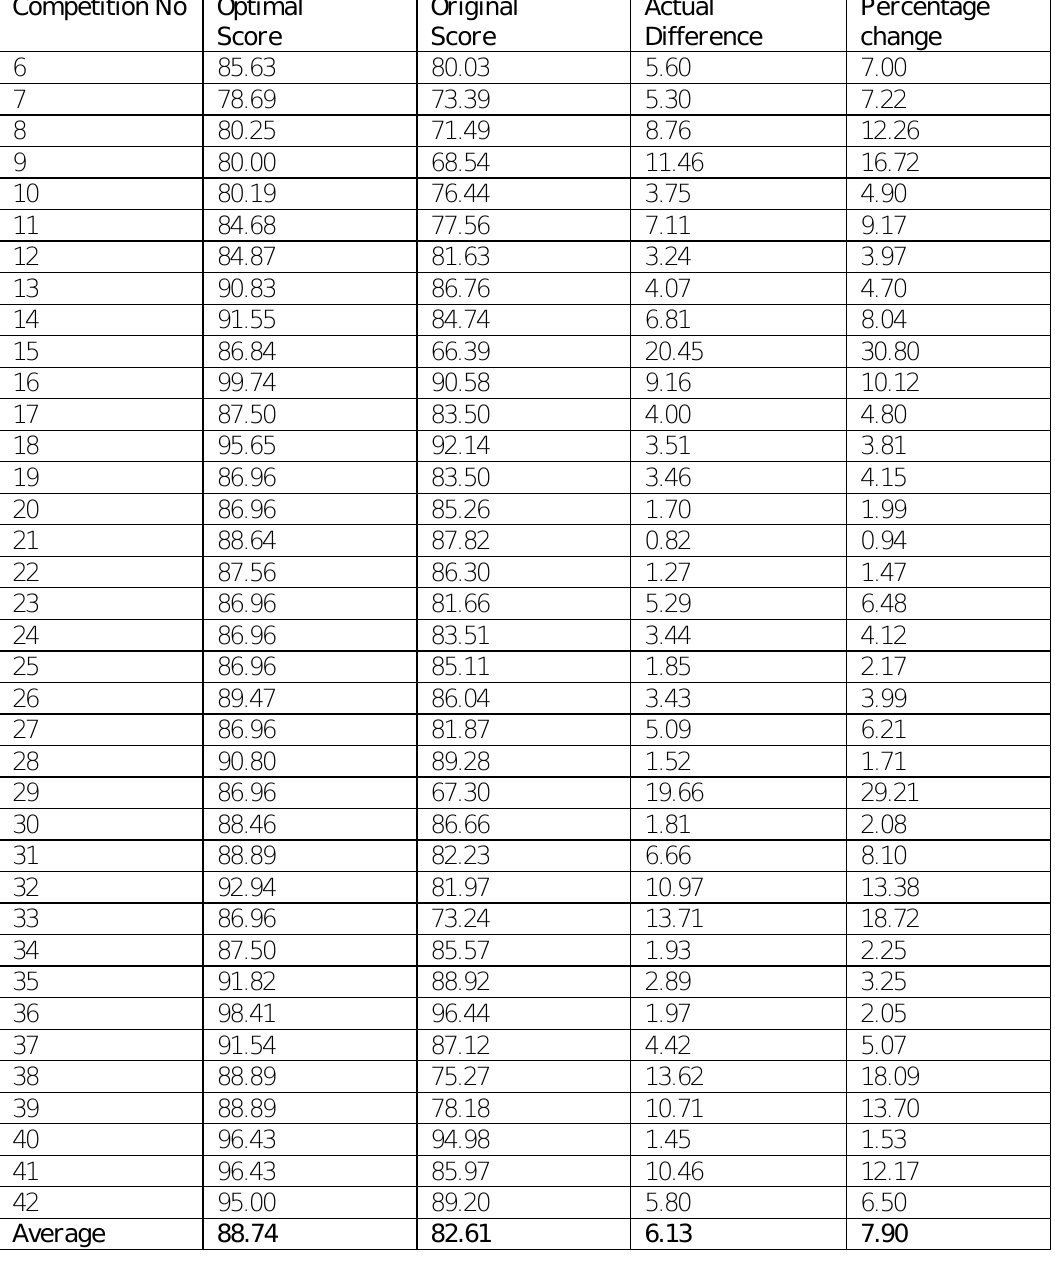
Table 5: Original total score/ optimum total score comparisons using 50/50 predetermined